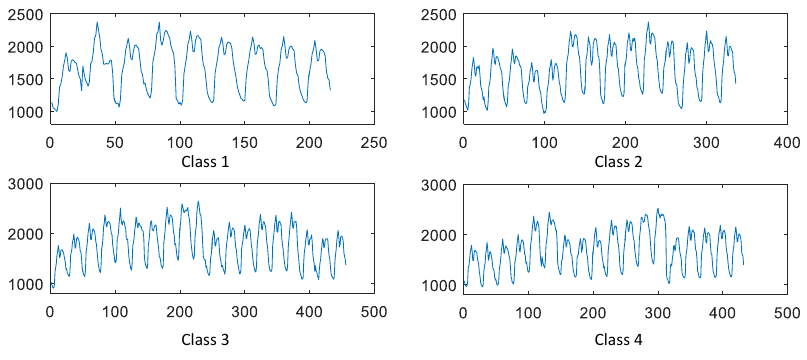
Figure 7 . The four types of power load curve.